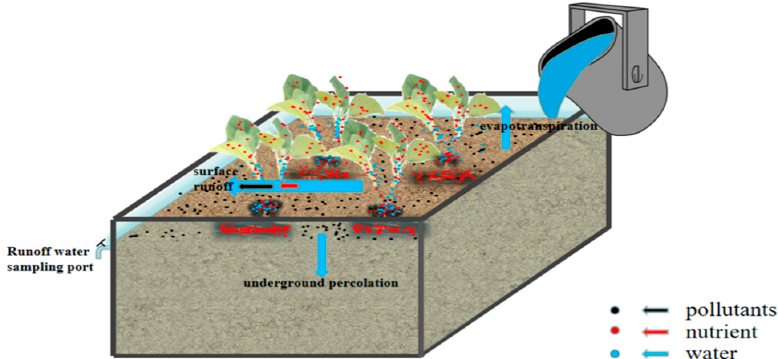
Figure 1. Schematic diagram of experimental equipment for crop-soil runoff water system. Six fertilization patterns were set in this experiment, and the applied nitrogen ferti- lizer was calcium ammonium nitrate (5Ca(NO 3 ) 2 -NH 4 NO 3 -10H 2 O); phosphorus fertilizer was calcium dihydrogen phosphate (Ca(H 2 PO 4 ) 2 ); and potassium fertilizer was potassium chloride (KCl). The fertilization amounts of the six fertilization patterns were shown in Table 1. Table 1. Fertilization scheme for six plots. Plot 5Ca(NO 3 ) 2 ·NH 4 NO 3 ·10H 2 O (kg/m 2 ) 0.18 CK 0 0 0 0 The system was irrigated and fertilized six times during the whole reproductive pe- riod, and irrigation was carried out 24 h after fertilization, and the amount of irrigation was set as shown in Table 2. Table 2. Irrigation amount of eggplant at different growth stages (unit: mm). Date